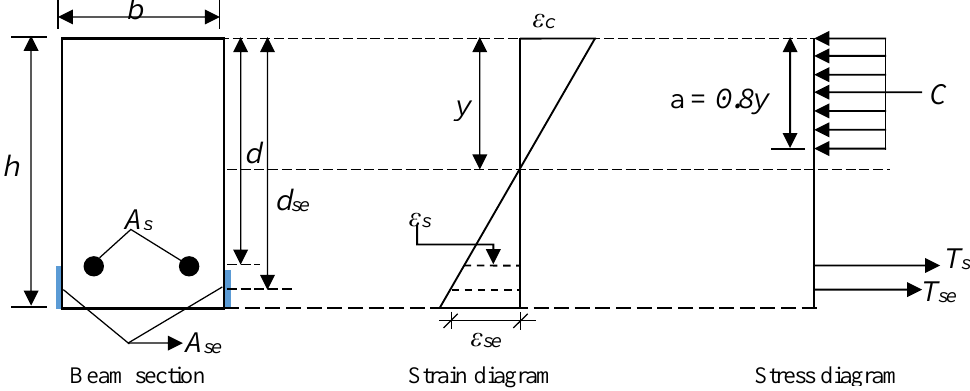
Figure 4. Section of E-SBR CFRP strengthened beams.